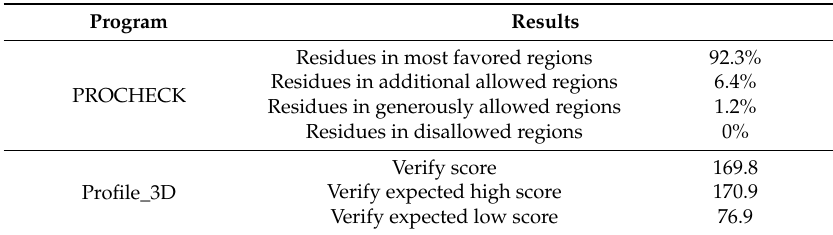
Figure 7. Homology modeling and molecular dynamics simulation of Pnserpin. ( a ) Model structure of Pnserpin. β sheet A, β sheet B and β sheet C are colored in red, green, and yellow, respectively; the reactive center loop (RCL) is colored in purple; ( b ) The Ramachandran plot of the model structure of Pnserpin. Dark grey, most favored region; grey, allowed region; light grey, generously allowed region. The residue numbers show the residues in the generously allowed region; ( c , d ) Average backbone RMSD and potential energy of 10 ns molecular dynamic simulation of the Pnserpin model structure. Table 2. The results of PROCHECK and Profile_3D